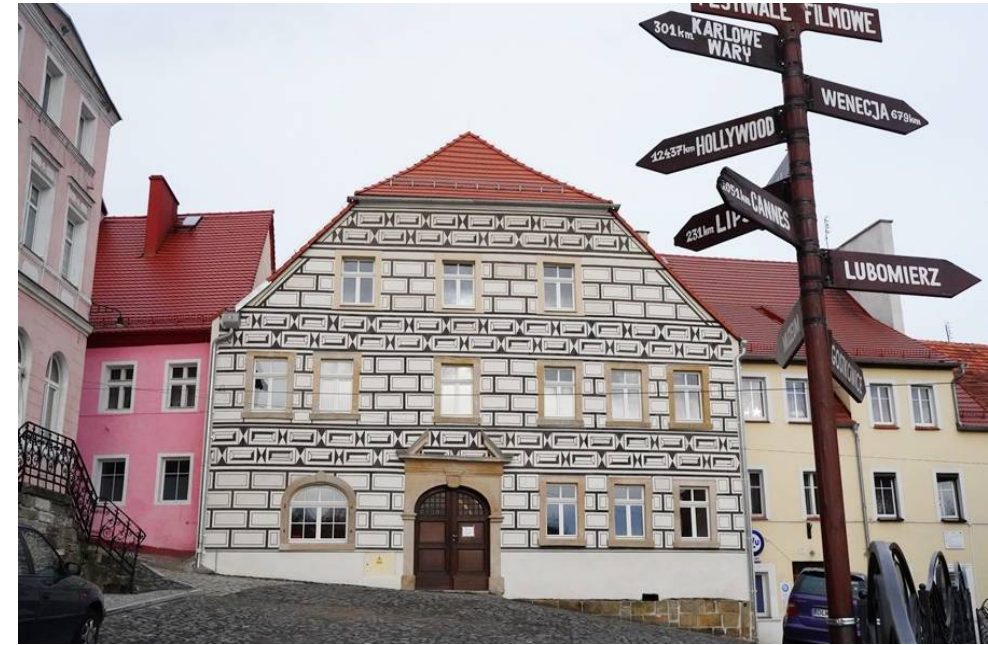
Figure 14. Reconstructed sgraffito decorations in the former House of Cloth Makers (Dom Płócienników) in Lubomierz, now the Kargul and Pawlak Museum. Photo by lwowecki.info, 2019.